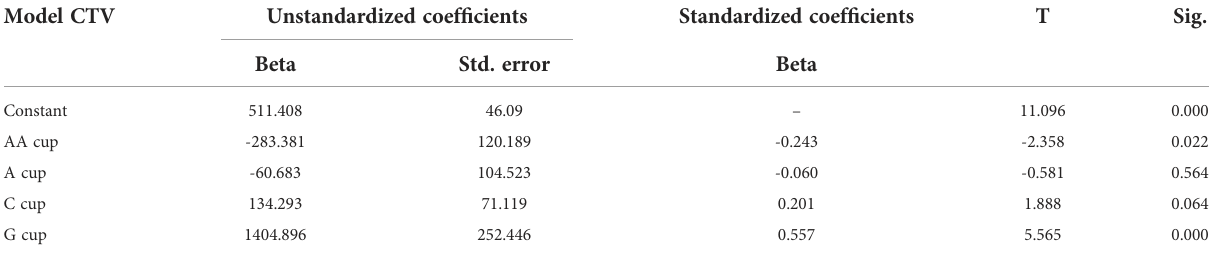
TABLE 5 Coef fi cients of Model CTV. Model